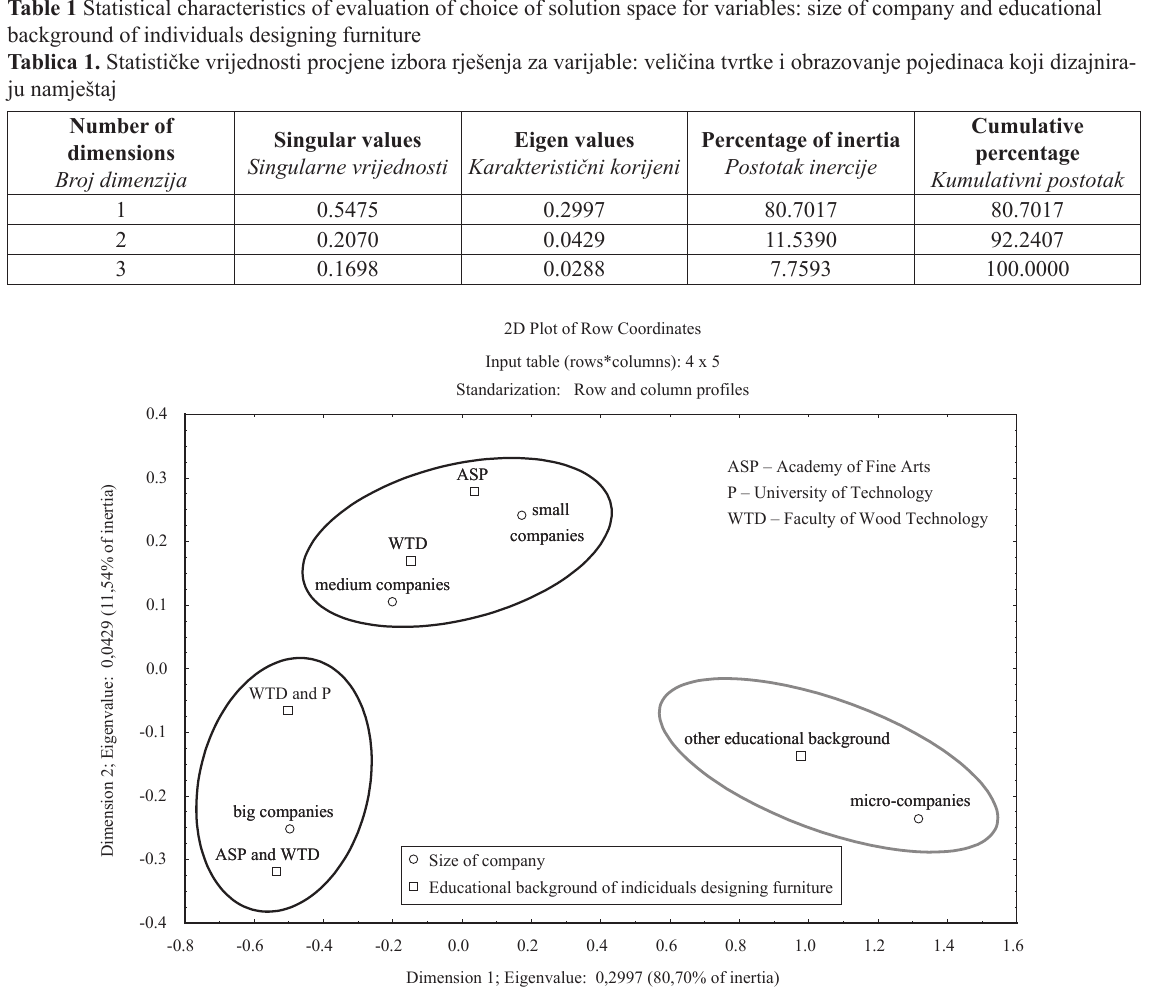
Table 1 Statistical characteristics of evaluation of choice of solution space for variables: size of company and educational background of individuals designing furniture